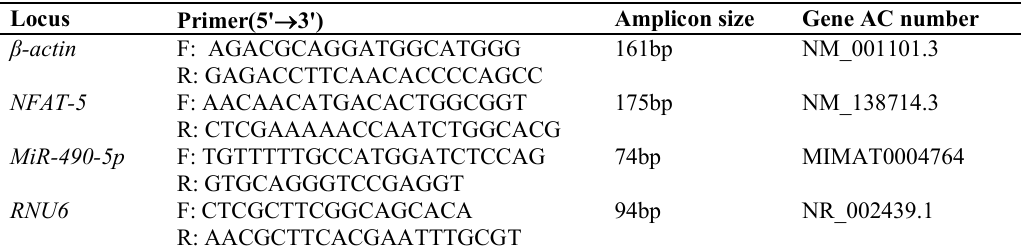
Table 1. Primers used in